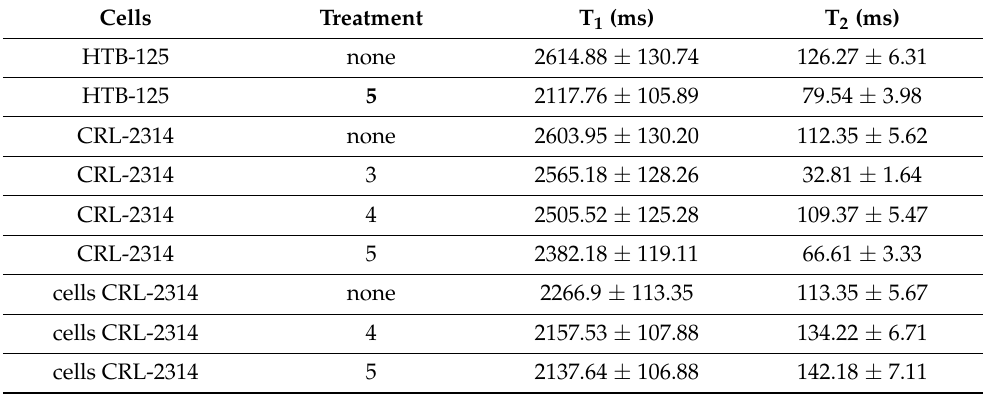
Table 2. Results of MR relaxation time